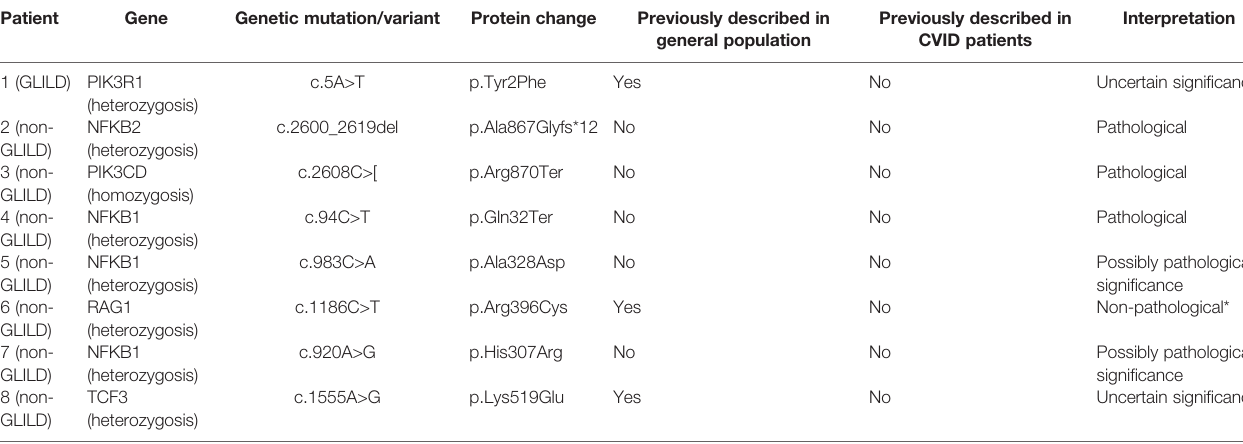
TABLE 2 | Description of the genetic mutations and variants.